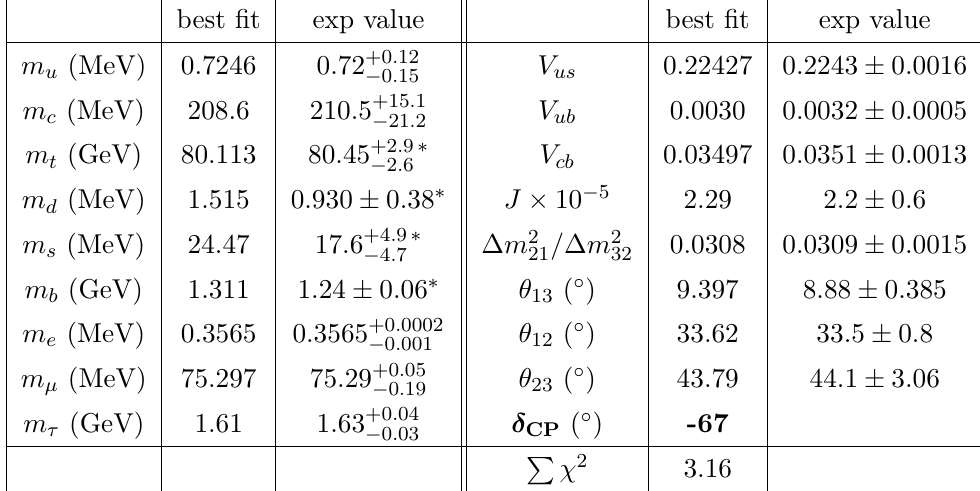
Table 4 . Fit values for the GUT-scale charged fermion masses, solar-to-atmospheric mass squared ratio, and CKM and PMNS mixing parameters for a sample (cid:12)t with Type-I seesaw. This (cid:12)t utilized the blue initial position for input from table 2. The 1 (cid:27) experimental values are shown [90] ( (cid:3) - [91]), [81]; masses and mixings are extrapolated to the GUT scale using the MSSM RGEs. Note that the (cid:12)t values for the bottom quark mass and the CKM mixing parameters involving the third generation shown here include threshold corrections.